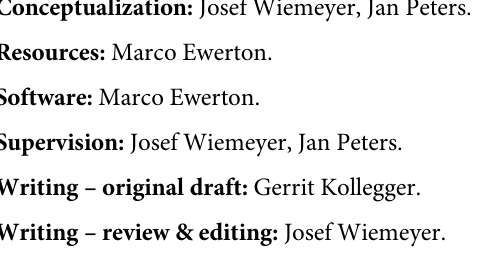
S1 Table. Descriptive statistics. Descriptive statistics and and results of the follow-up analyzes for experiment 1 and experiment 2. S2 Table. Detailed results of the subgroup analysis. Results of the two-factor ANOVA with repeated measures (6 distances; 2 vision conditions) for the predicted distance, the CE and the confidence for the two subgroups in experiment 1 and of the two-factor ANOVA with repeated measures (3 distances; 4 vision conditions) for the predicted distance, the CE and the confidence for the two subgroups in experiment 2. Corrected by Greenhouse-Geisser �